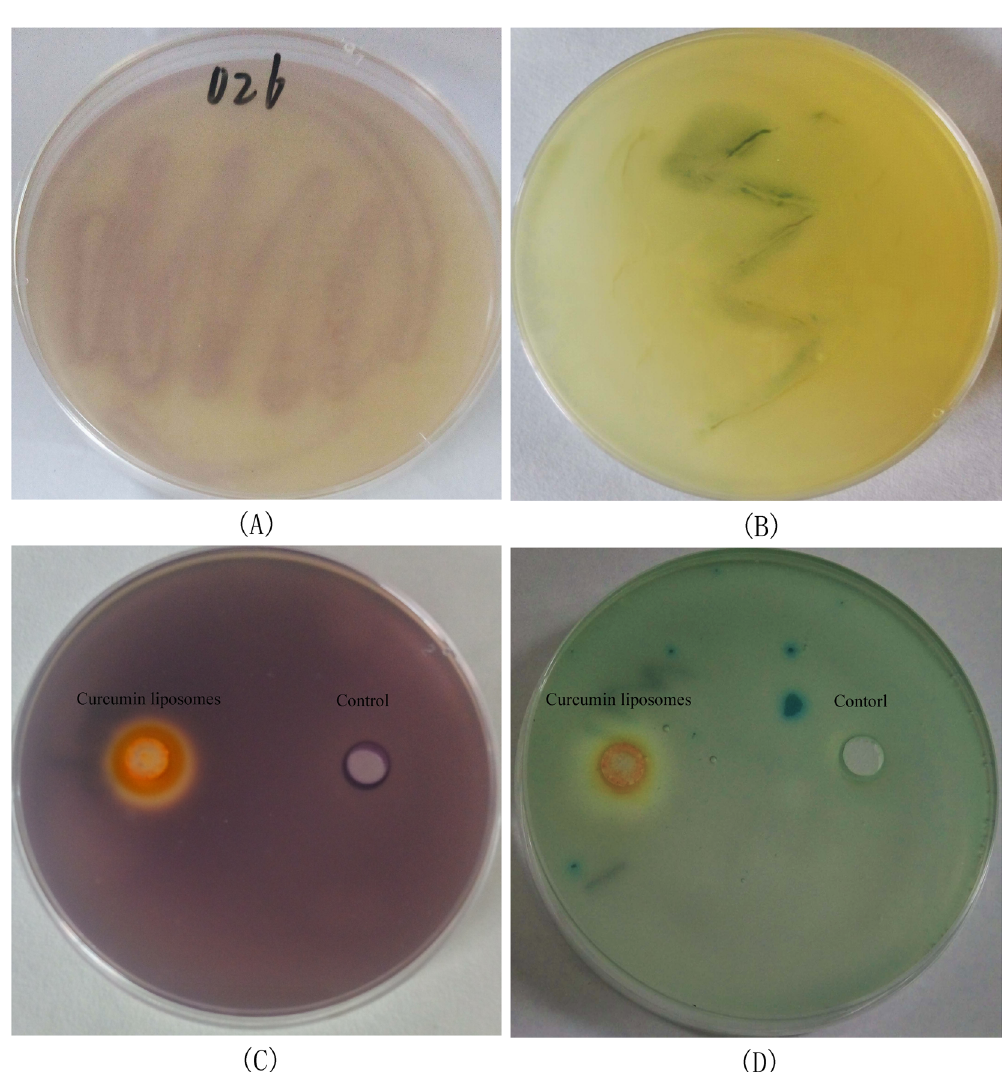
Figure 2. Detection of AHLs produced by A. sobria via indicator bacteria of C. violaceum CV026 ( A ) and A. tumefaciens A136 ( B ) as well as violacein inhibition assay ( C ) and β -galactosidase assay ( D ) of curcumin